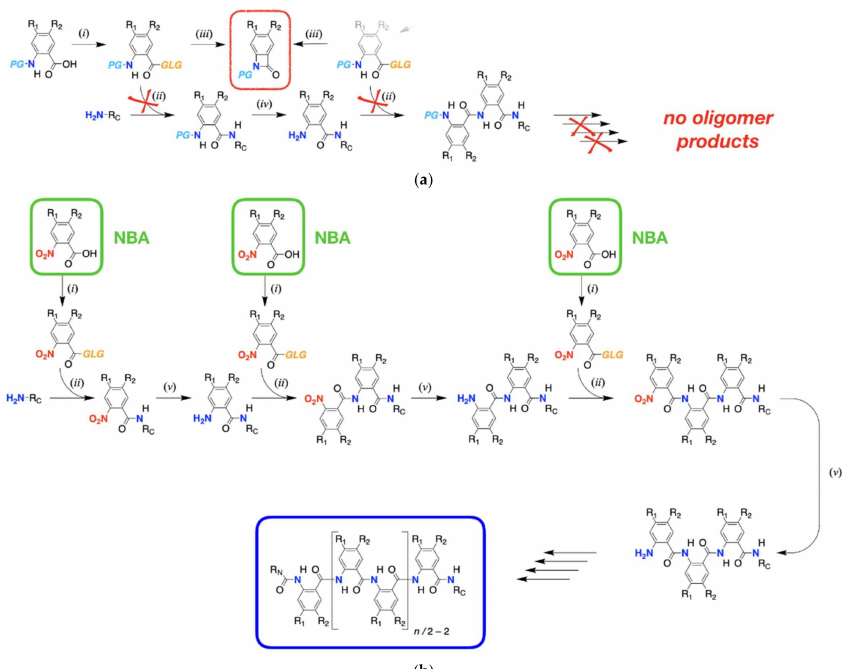
Figure 2. Synthesis of bioinspired molecular electrets composed of Aa residues. ( a ) An established protocol for peptide synthesis where each residue is introduced as its protected-amine derivative, with a protection group ( PG ) such as Fmoc or t Boc. Ideally, the synthesis of the polyamide molecular electrets should involve a sequence of repetitions of carboxylate-activation ( i ) and amide-coupling ( ii ) steps, followed by amine deprotection ( iv ). The enormous efficiency of the intramolecular formation of stable cyclic β -lactams (in the red frame) ( iii ), however, precludes the intermolecular amide coupling ( ii ), rendering this synthetic strategy unacceptable. ( b ) An alternative protocol for the synthesis of Aa molecular electrets with n Aa units (in the blue frame), capped with R N and R C at the N- and C-termini, respectively, where each residue is introduced as its 2-nitrobenzoic acid (NBA) derivative (in the green frames). The multistep synthesis involves repetitions of carboxylate activation ( i ), amide coupling ( ii ), and nitro reduction ( v ). Steps ( i ) and ( ii ) can be carried out separately or in the same pot involving in situ carboxylate activation in the presence of the free amine. Specifically, the involved reaction steps are: ( i ) activation of the carboxylic acid by attaching a good living group ( GLG ) to the electrophilic carbonyl carbon via: ( i. 1) halogenation (i.e., GLG = -Cl or -F); ( i. 2) a reaction with a carbodiimide reagent in the presence of hydroxyl derivatives such as N -hydroxysuccinimide (HOSu) (i.e., GLG = -OSu, 1-hydroxybenzotriazole (HOBt), i.e., GLG = -OBt, or 1-hydroxy-7-azabenzotriazole (HOAt), i.e., GLG = -OAt); ( i. 3) a reaction with an onium reagent such as HOBT or HATU in the presence of HOBt or HOAt; ( ii ) coupling between the activated acid and a primary (or secondary) amine (i.e., amide coupling); ( iii ) formation of a stable cyclic β -lactam (in the red frame): the close proximity of a weakly nucleophilic nitrogen (in a protected amine or in an amide) at the ortho position to the activated carboxylate makes it immensely prone to intramolecular amide coupling leading to a cyclic lactam; ( iv ) deprotection of the amine (e.g., using base for Fmoc PG , and acid for t Boc PG ), and ( v ) selective reduction of the N-terminal nitro group to an